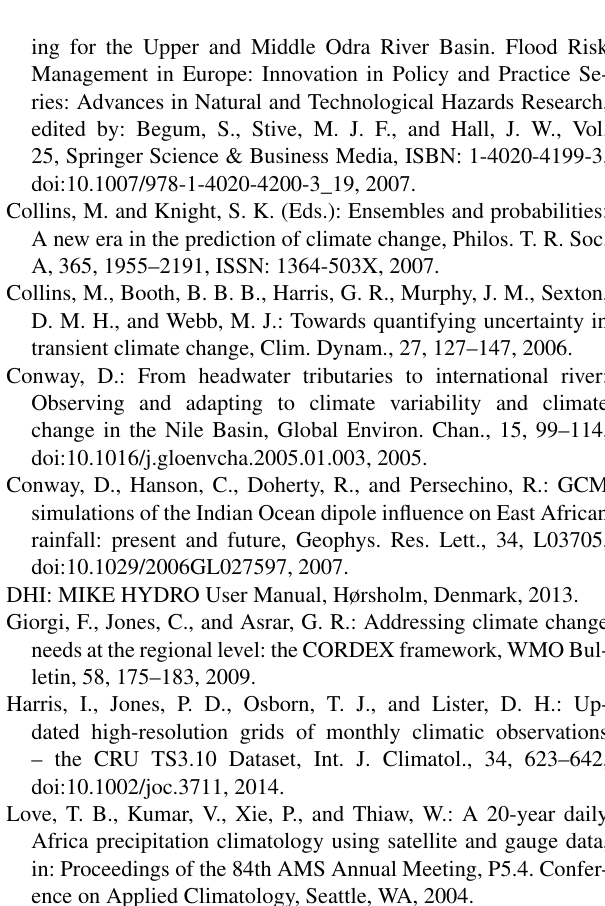
Figure 4. Projected changes in the average monthly flows (upper) and flow duration curve (lower) for 2020–2049 (left) and 2070–2099 (right) for the Jinja station. The solid (red) line shows the baseline levels (1961–1990) and the thin green lines show the variability among the 5 RCM ensemble